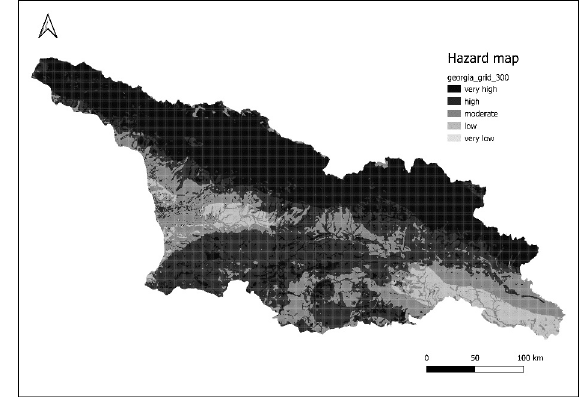
Figure 9. Multi factor (seismic, landslide, mudflow, rockfall) hazard